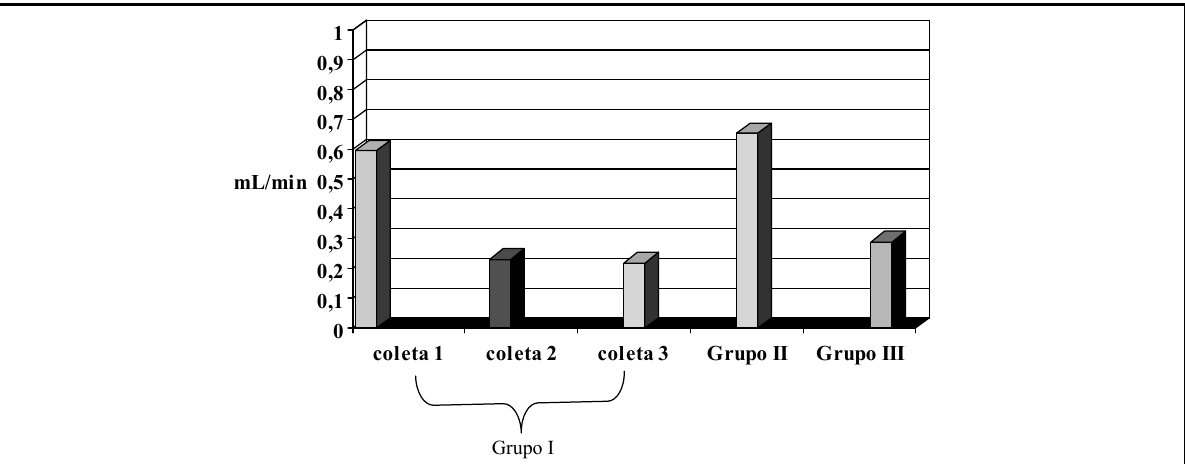
Figura – Distribuição do fluxo salivar nos grupos I, II e III a partir de amostras obtidas em coletas isoladas não estimuladas (grupos II e III) e coletas no início, meio e fim do tratamento radioterápico (grupo